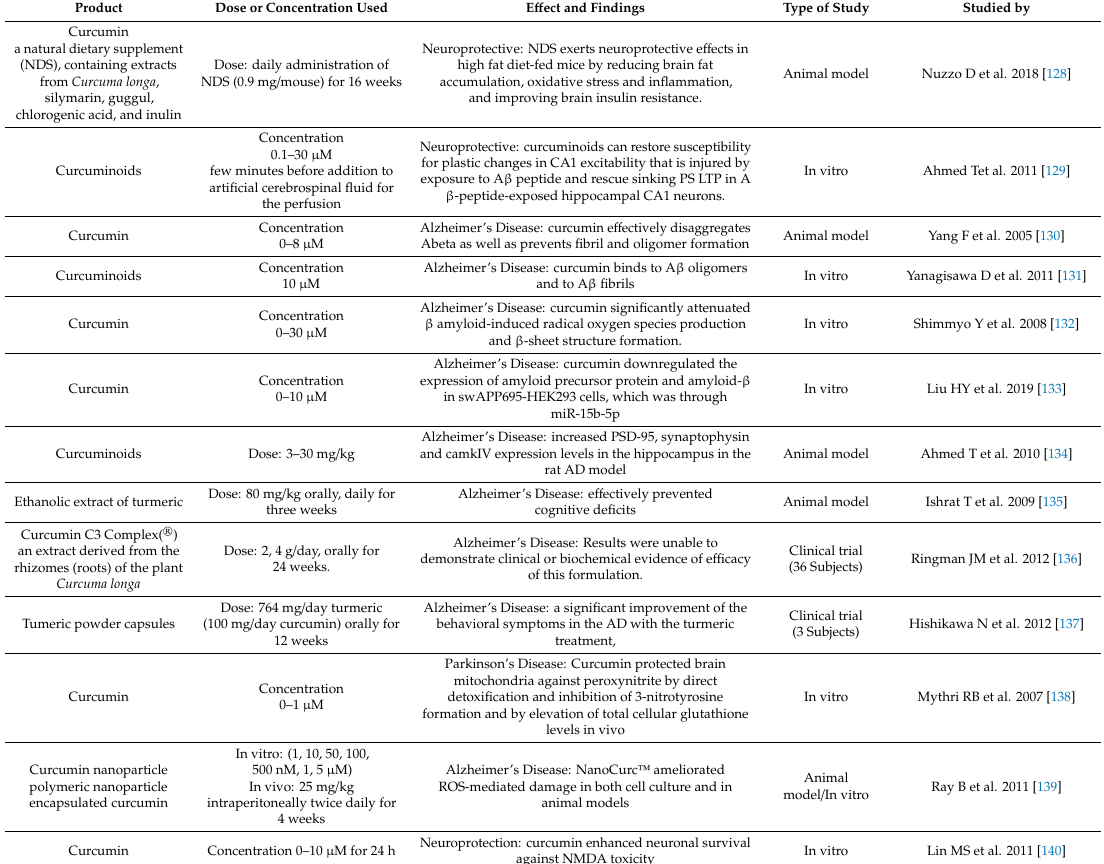
Table 6. Neuroprotective E ff ect of Curcumin in Neurodegenerative Diseases. Product DoseorConcentrationUsed E ff ectandFindings